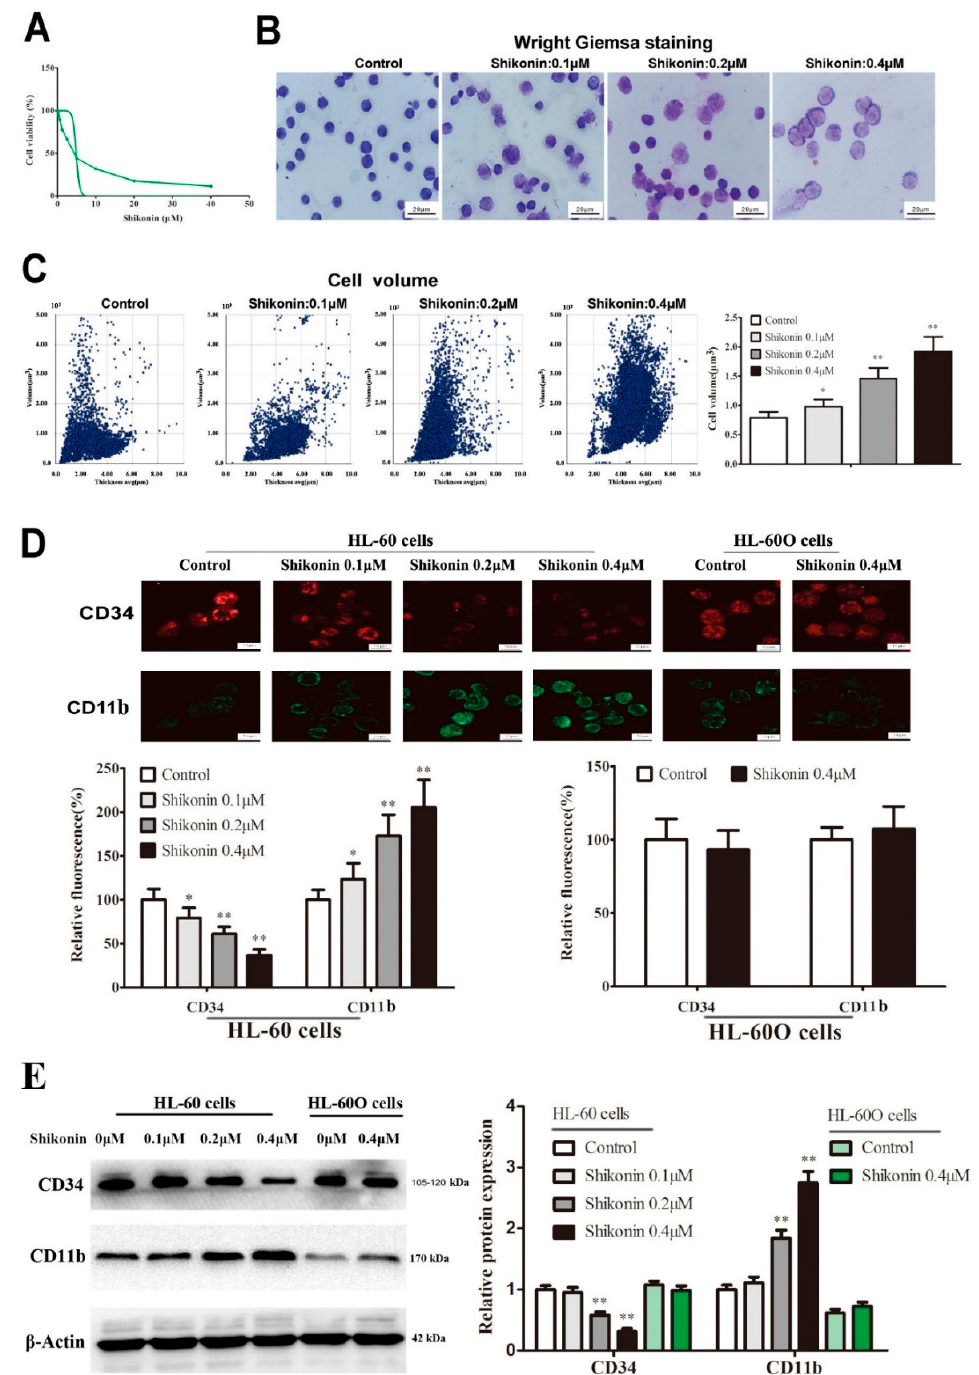
Figure 4. Shikonin promotes leukemia cell differentiation. HL-60 cells were treated with shikonin for 48 h. ( A ) Cell viability was detected by MTT assay. ( B ) Cell morphology was detected by Wright Giemsa staining. ( C ) The cell volume distribution was detected by the Holomonitor system. ( D ) The expression of CD34 and CD11b was detected by immunofluorescence in HL-60 cells. ( E ) CD34 and CD11b protein expression was detected by Western blot. The data were presented as the mean ± SD (n = 3). * p < 0.05; ** p < 0.01 compared to the untreated control.